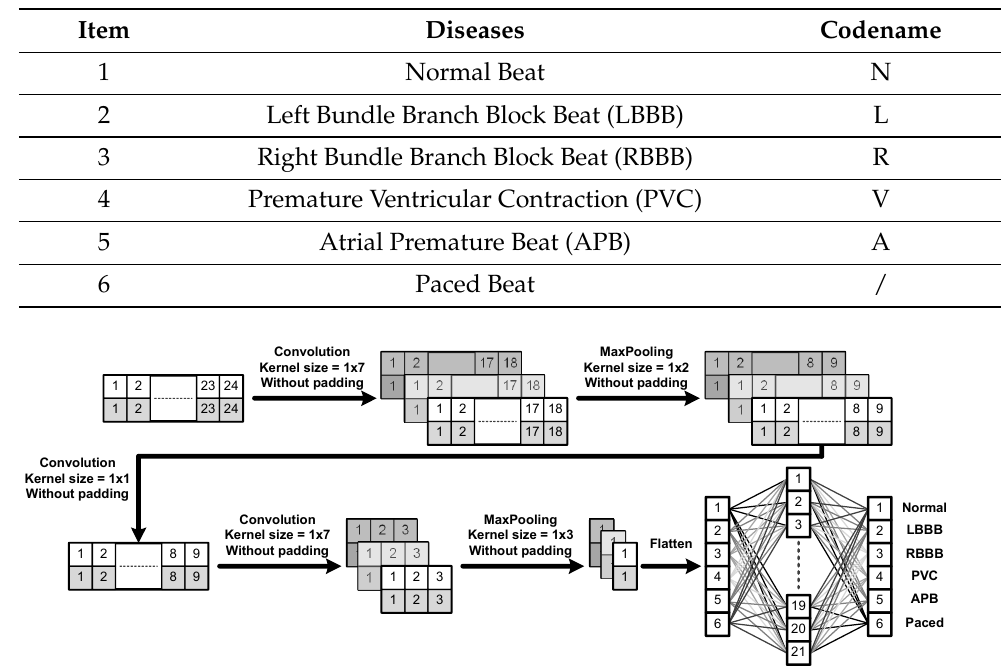
Table 1. Listing of different types of ECG heart beats drawn from the MIT-BIH arrhythmia database to be detected.